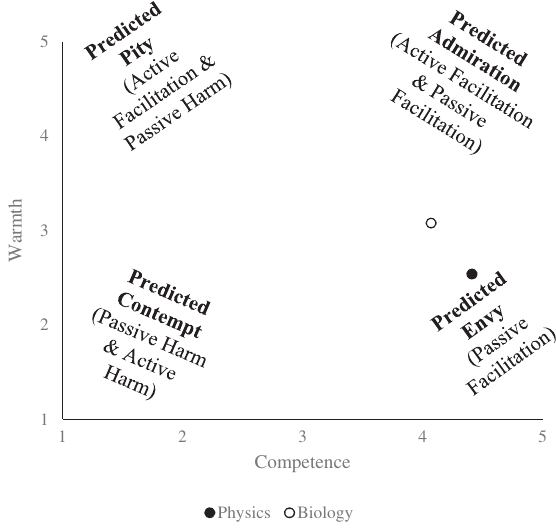
FIG. 4. Scatter plot of results for physicists and biologists on competence and warmth ratings. BIAS map emotion predictions are represented within the figure [51]. Actual emotion results are reported in Fig. 3. See Table I for sample